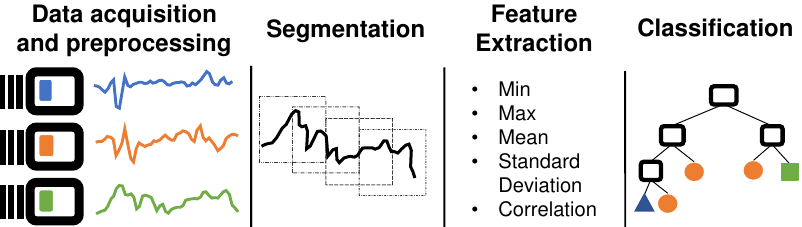
Figure 1. The common methodology used in HAR: data acquisition, segmentation, feature extraction, and